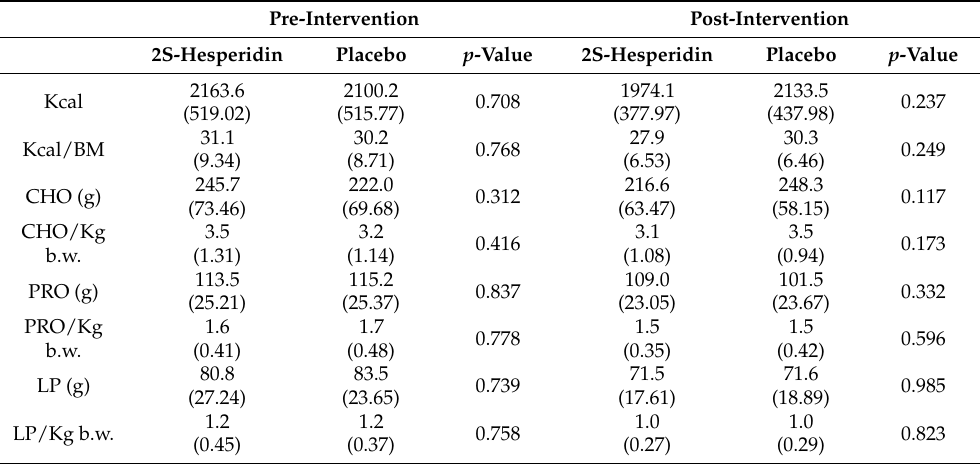
Table 3. Between-group comparisons in dietary intake of